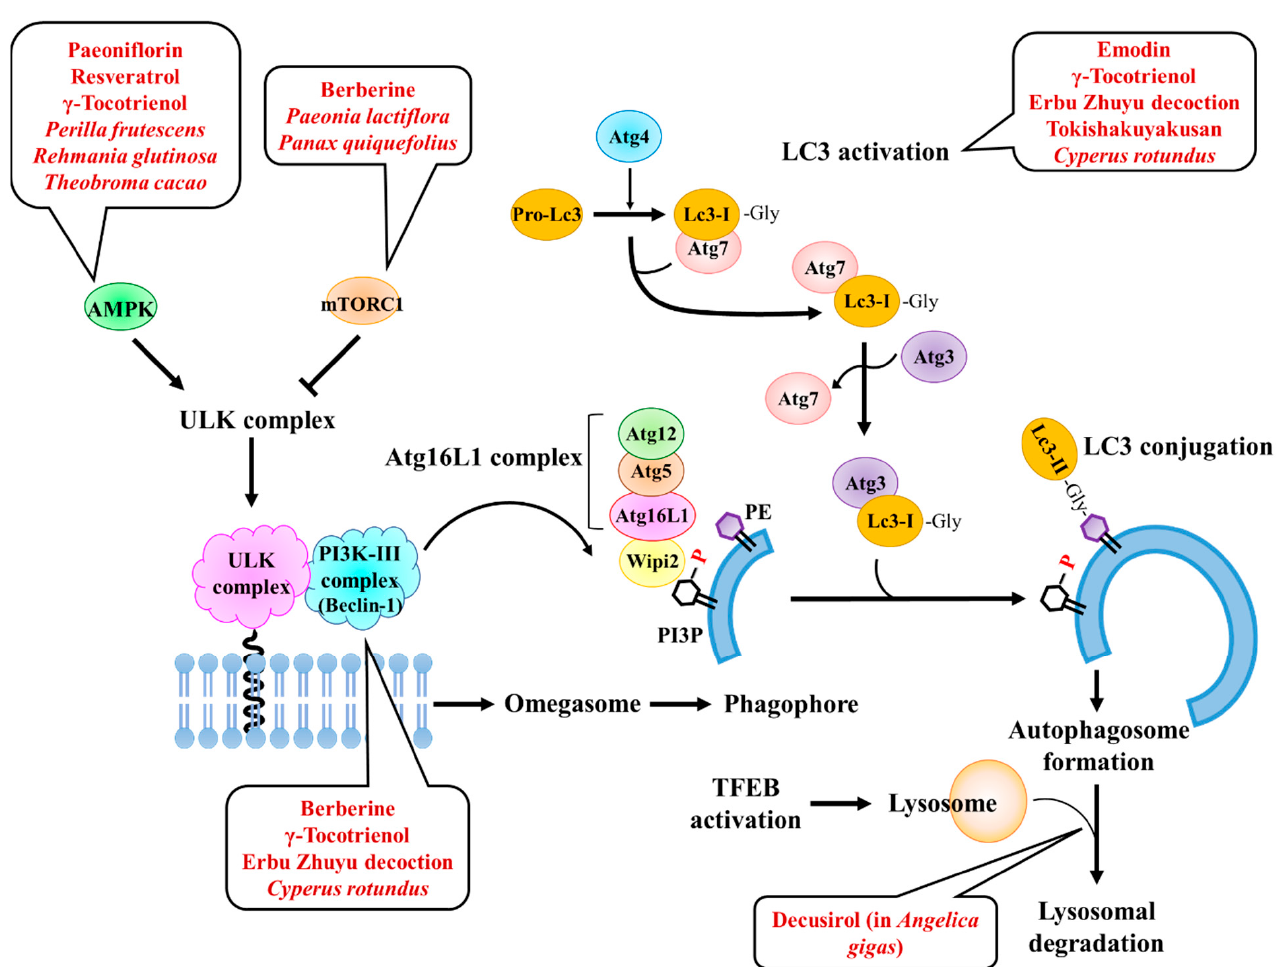
Figure 5. The proposed mechanisms of natural products that enhance embryo implantation. Paeoniflorin, resveratrol, γ -Tocotrienol, Perilla frutescens , Rehmannia glutinosa , and Theobroma cacao activate AMPK and thereby induce autophagy. Berberine, Paeonia lactiflora , and Panax quinquefolius inactivates mTORC1. Berberine, γ -Tocotrienol, Erbu Zhuyu decoction, and Cyperus rotundus reduced Beclin1. Emodin, γ -Tocotrienol, Erbu Zhuyu decoction, Tokishakuyakusan, and Cyperus rotundus increase LC3 expression and/or its activation. Decusirol isolated from Angelica gigas interferes with autophagic flux. Abbreviations: AMPK, AMP-activated protein kinase; Atg, autophagy-related gene; mTOR, mammalian target of rapamycin kinase; Lc3, microtubule-associated proteins 1 light chain 3.